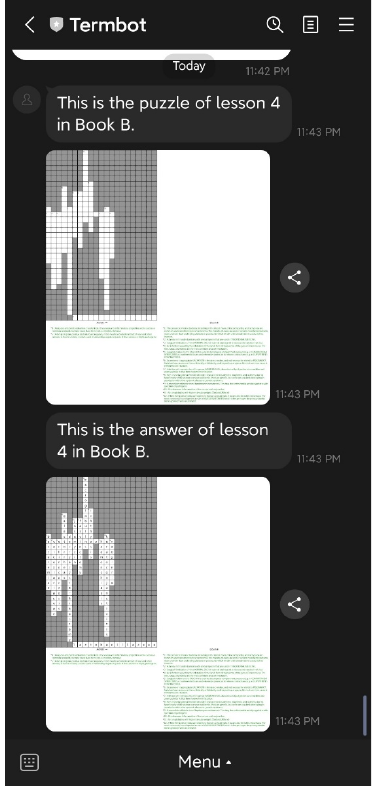
Figure 8. The puzzle and the answer are generated by the function “Auto generate”.